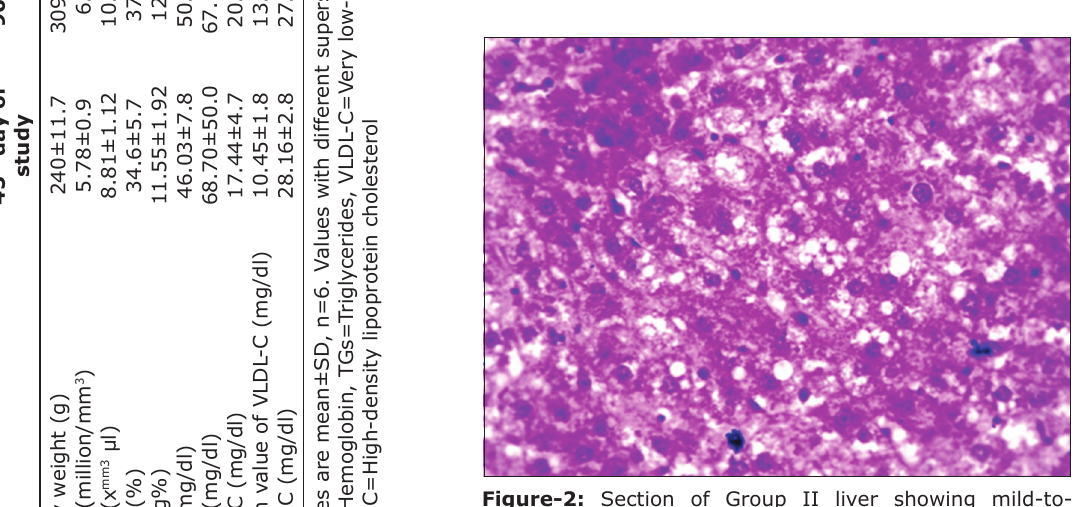
Figure-1: Liver: Note the reduced enlargement and paleness of flaxseed supplemented Group IV liver compared to high cholesterol diet Group II liver.